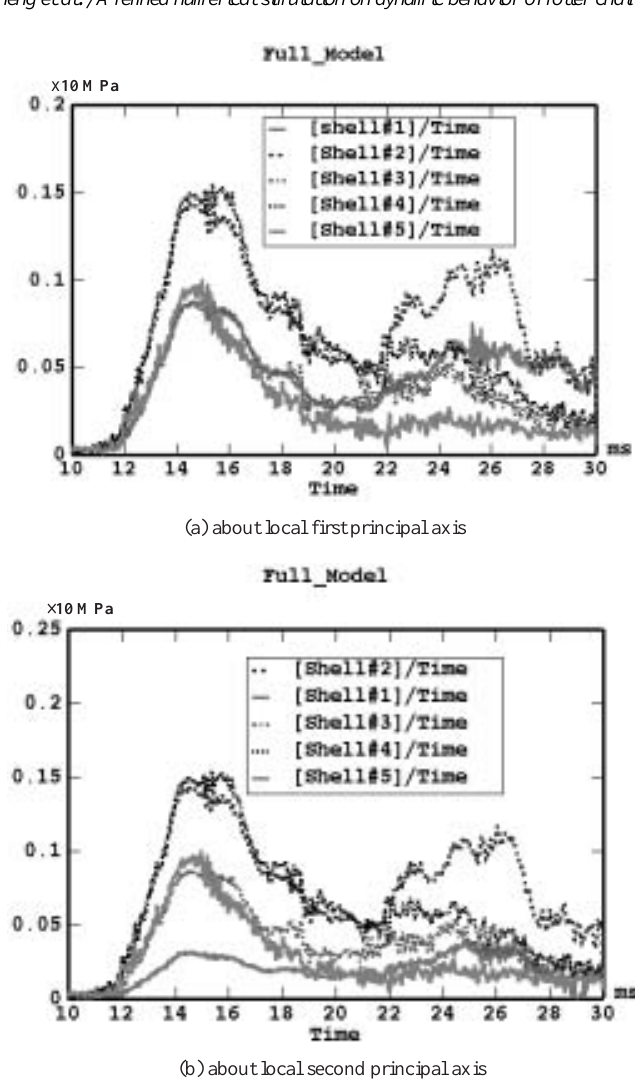
Fig. 9. Stress of shell elements in side connecting